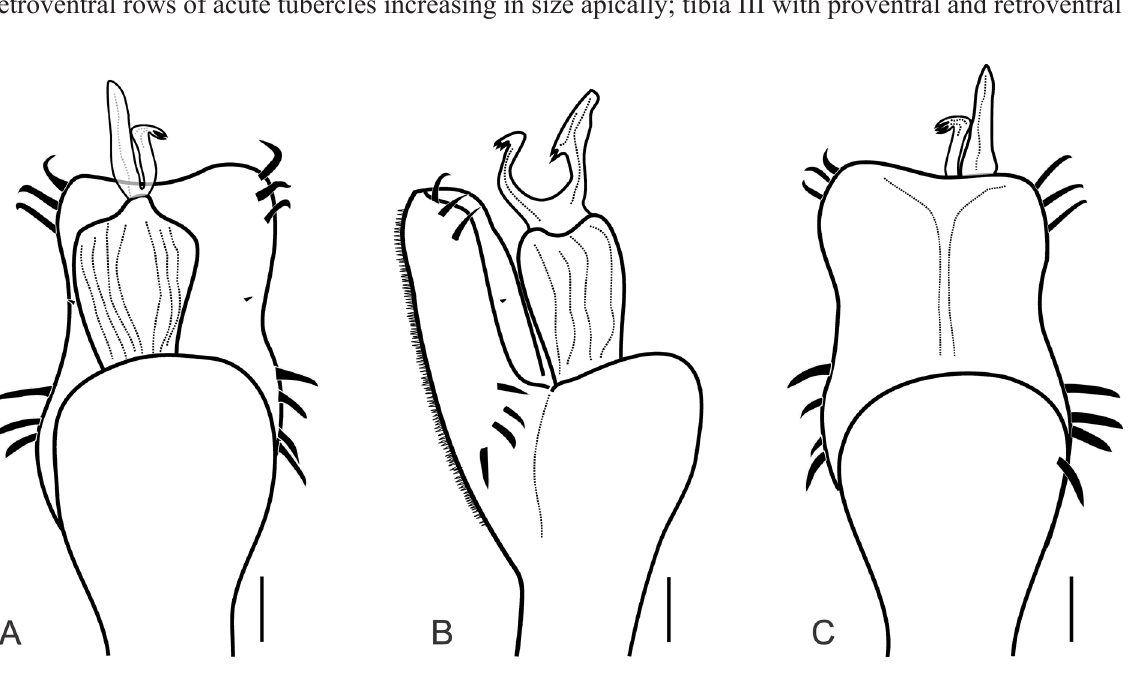
Fig. 9. Eusarcus xambioa sp. nov., ♂, holotype (ISLA 60386), distal part of penis. A . Dorsal view. B . Ventral view. C . Right lateral view. Scale bars = 50